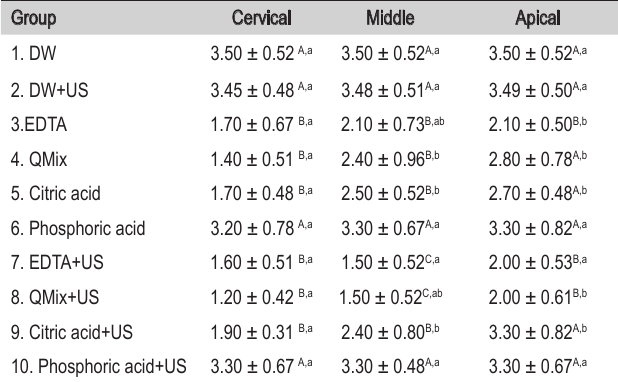
Table 1 - Mean and standard deviation of smear layer scores for each